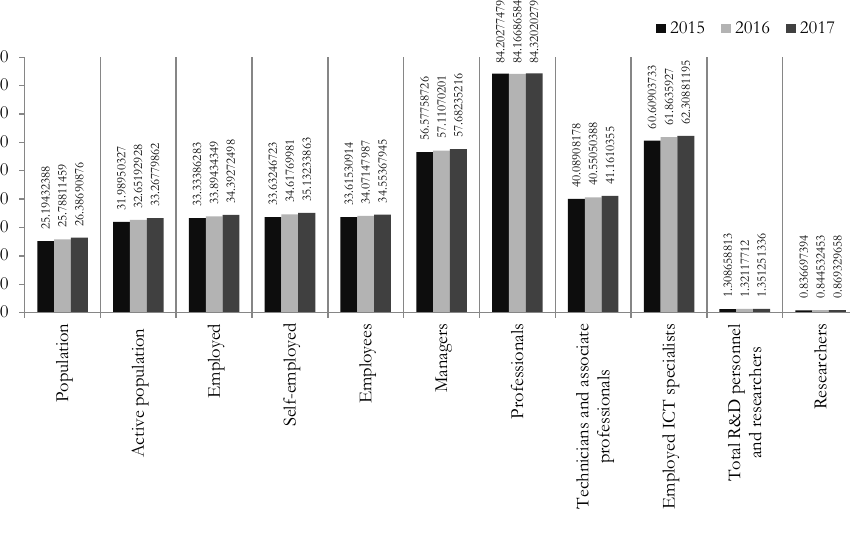
Fig. 3 – Dynamics of shares of population with tertiary education by employment status in EU member states for 2015-2017 (in%). Source: calculations based on data from Eurostat, 2019a-g